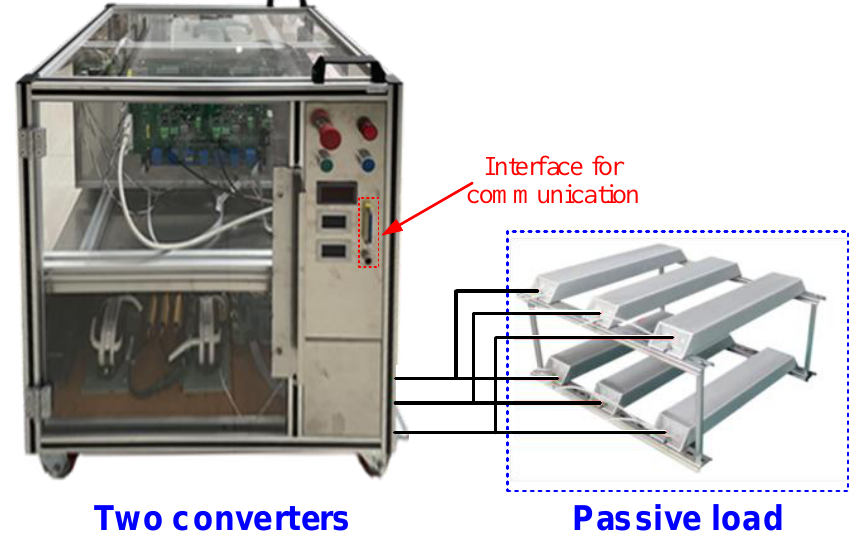
Figure 6. Experimental platform of proposed emulation approach. Table 1. Parameters of the experimental